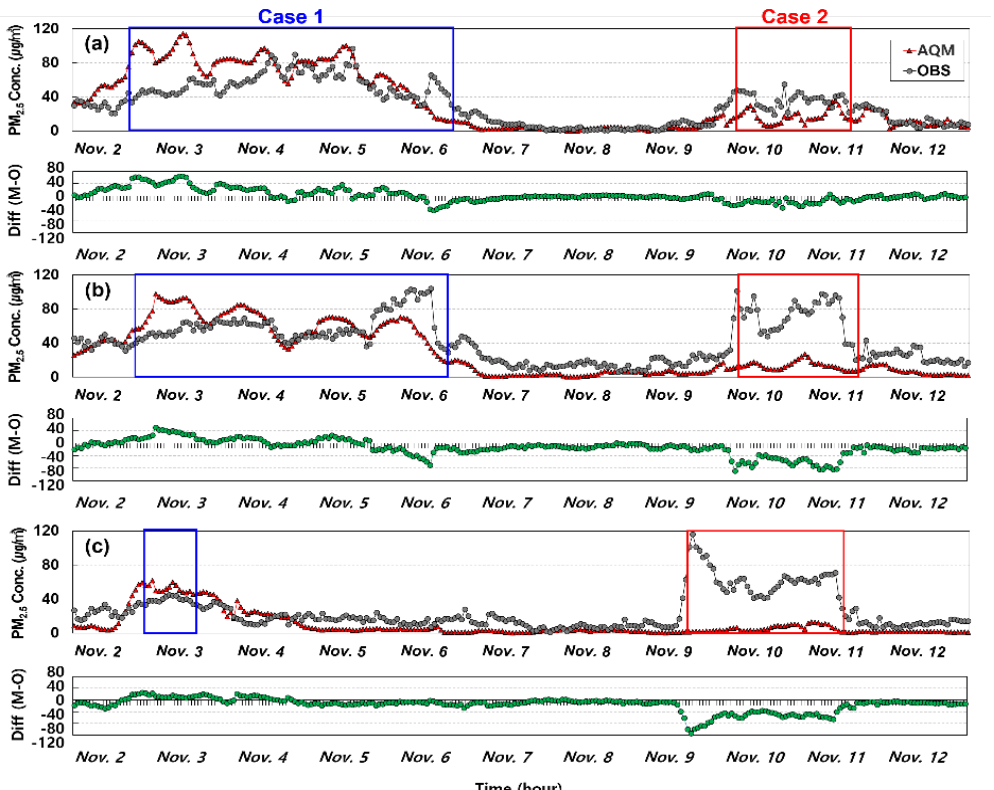
Figure 5. Variations and differences between in PM 2.5 simulated air quality model (AQM) and observation (OBS) values for PM 2.5 at ( a ) SMA-IAMS, ( b ) JB-IAMS, and ( c ) JJ-IAMS.